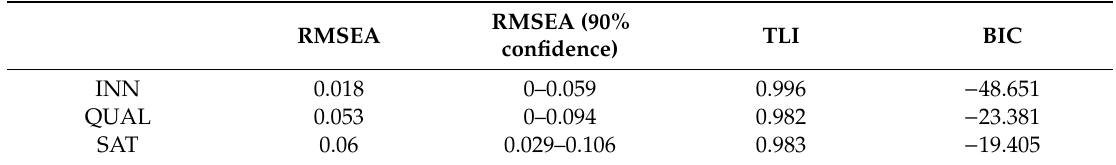
Table 5. Additional fit